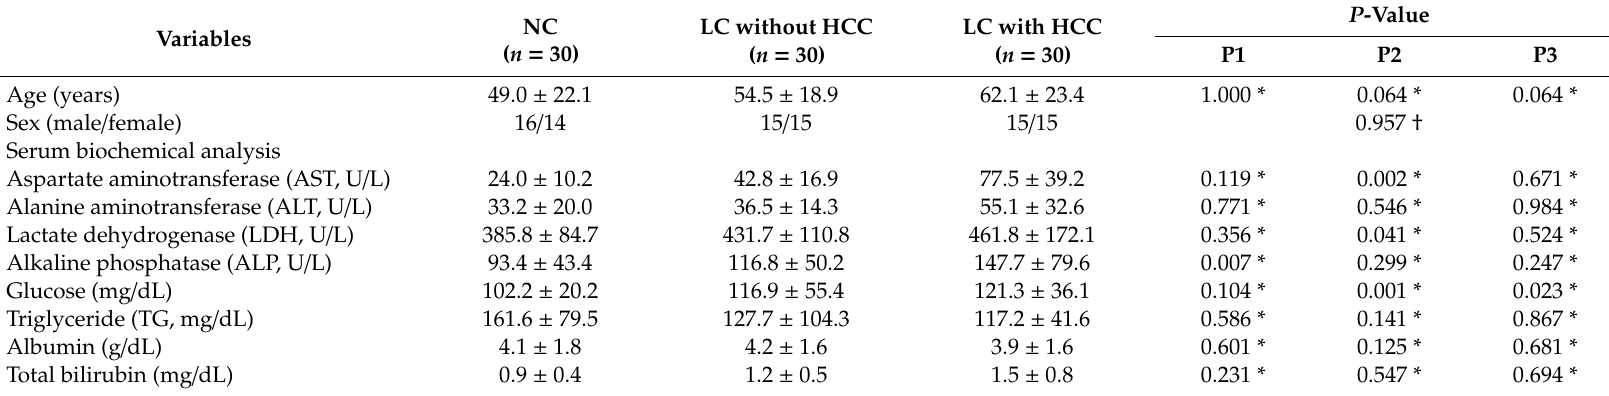
Table 1. Comparison of demographics and serum biochemical analysis among NC, LC without HCC, and LC with HCC groups.